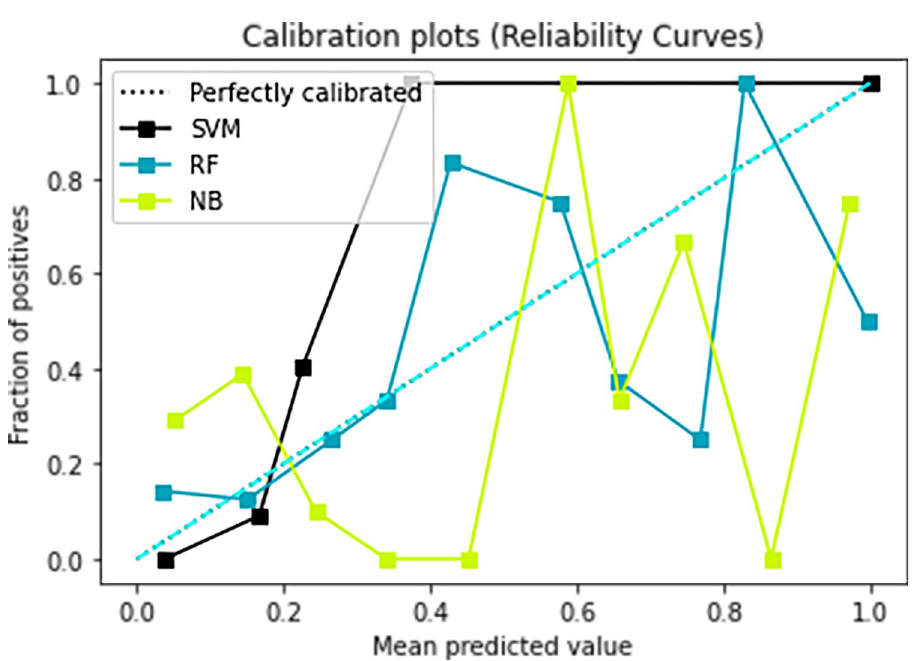
Fig 10. Calibration plots of the three candidate models for the prognosis of IgAN without ’Crescent proportion’ and ’Global crescent proportion’.